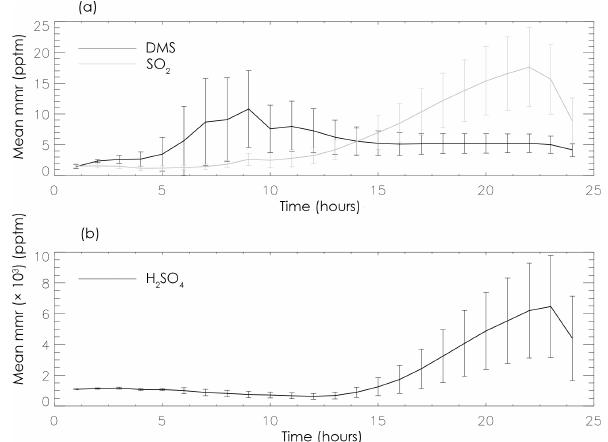
Figure 4. Temporal evolution of the mean mass mixing ratios of the gas precursors to aerosols. The DMS, SO 2 , and H 2 SO 4 mass concentrations are in pptm (part per trillion in mass). The error bars correspond to ± 1 standard